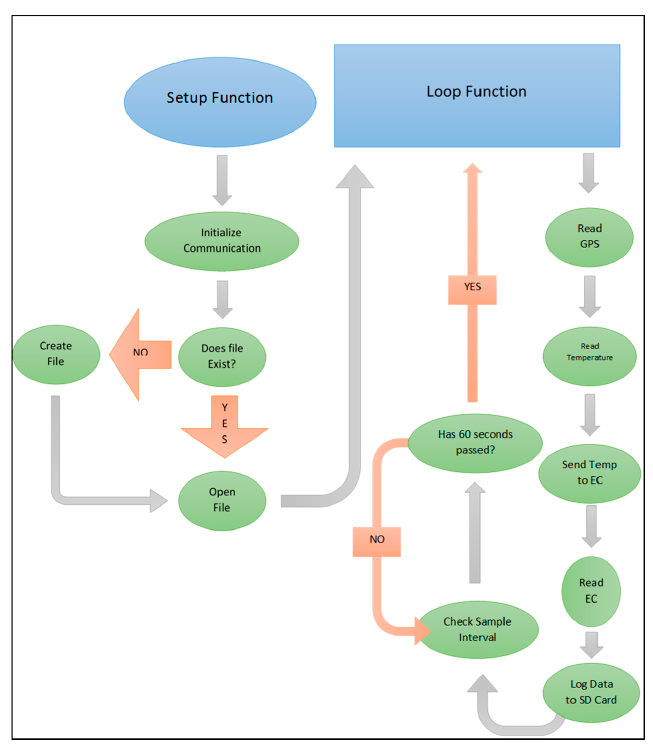
Figure 3. Programming logic followed by the sonde used for the drifter